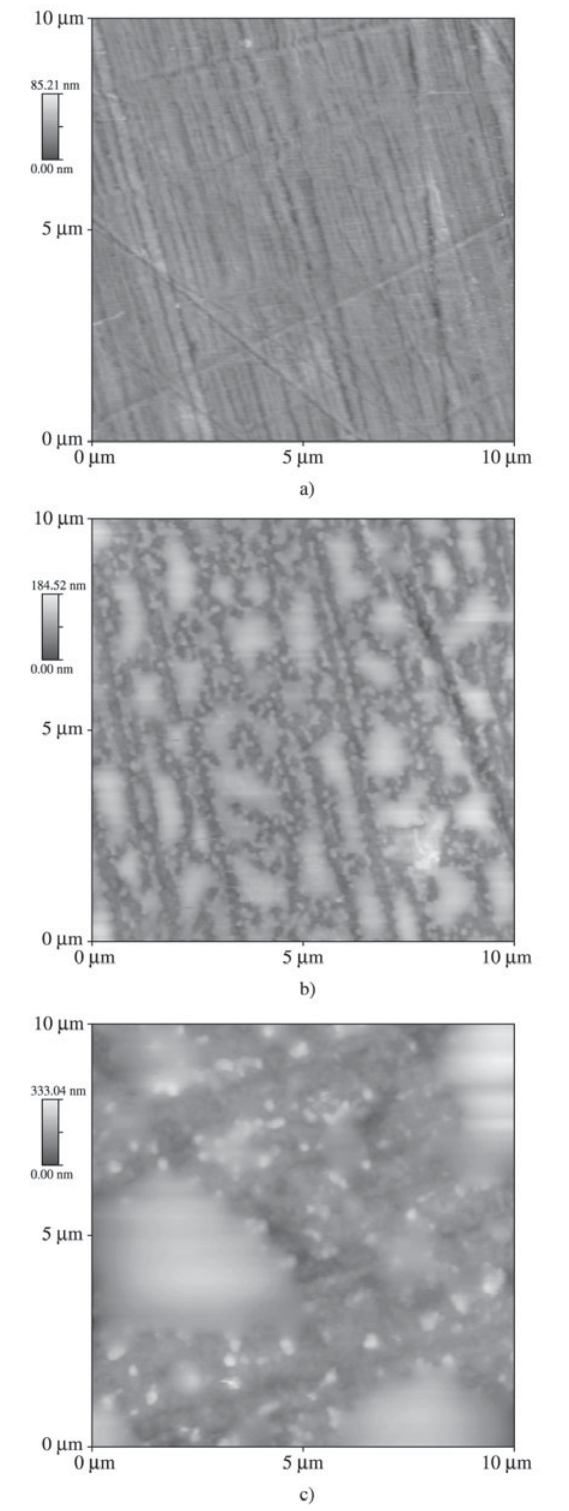
Figure 3. AFM topographic images for (a) untreated; (b) 2 s; (c) 30 s corona treated PP films.